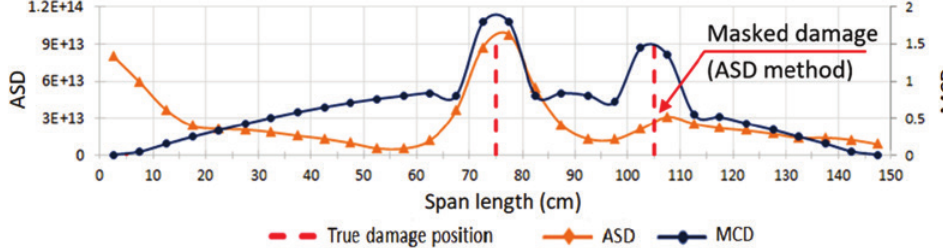
Figure 13 Comparison of the results obtained by ASD and MCD methods for the model with two